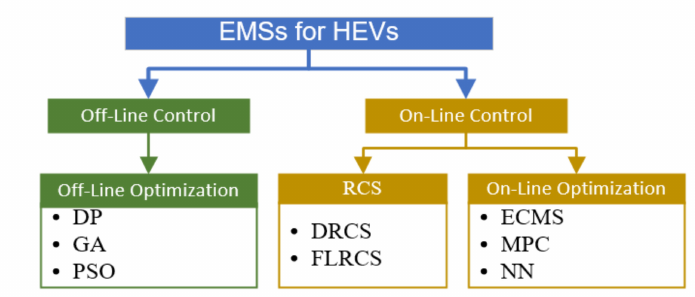
Figure 21. Classification based on real-time